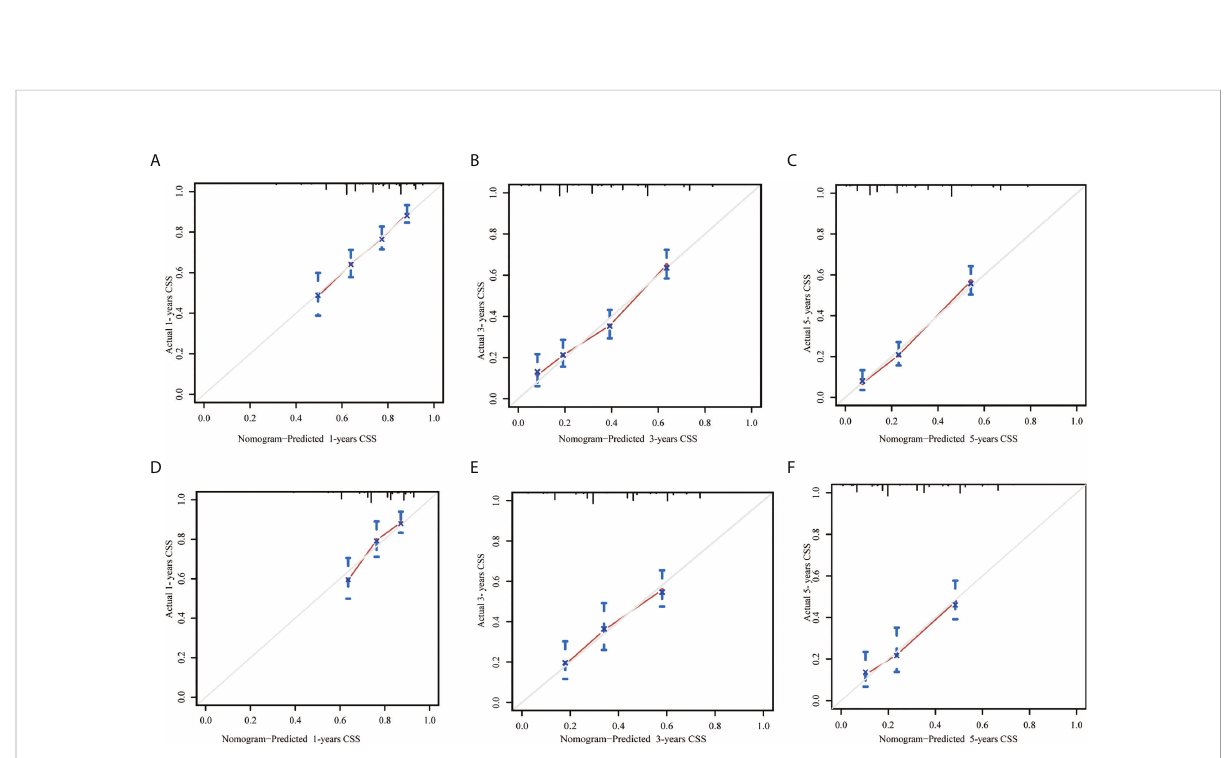
FIGURE 4 Calibration curves for predicting 1-, 3- and 5-year cancer-speci fi c survival in patients with early-onset pancreatic cancer after surgery in the training set (A – C , respectively ) and in the internal validation set (D – F , respectively ) . The X-axis represented the nomogram-predicted probability of CSS and the Y-axis represented actual observed survival. The diagonal grey line represents an ideal evaluation where the predicted probabilities were identical to that of actual observed. CSS, cancer-speci fi c